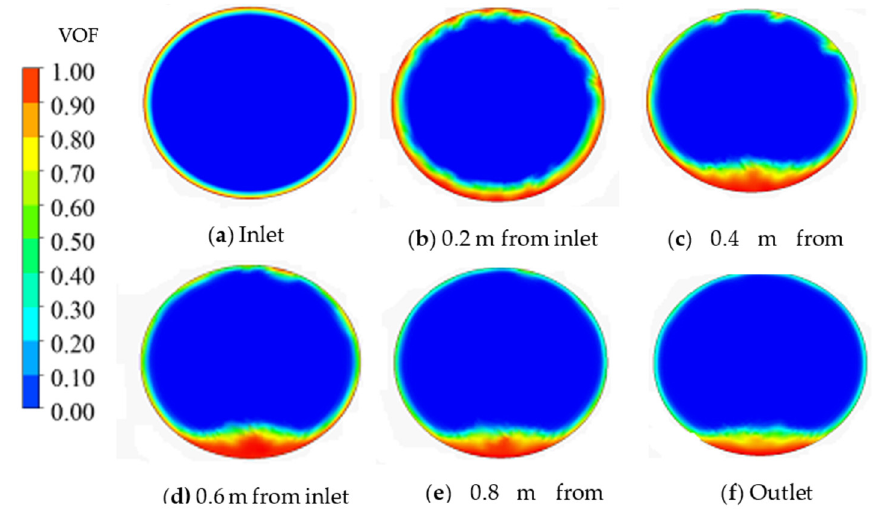
Figure 14. Contours of the liquid film distributions at six successive cross-sections from the inlet to the outlet, represented by the water volume of fraction (VOF). ( a ) Inlet; ( b ) 0.2 m away from inlet; ( c ) 0.4 m away from inlet; ( d ) 0.6 away from inlet; ( e ) 0.8 m away from inlet; ( f ) outlet, respectively.